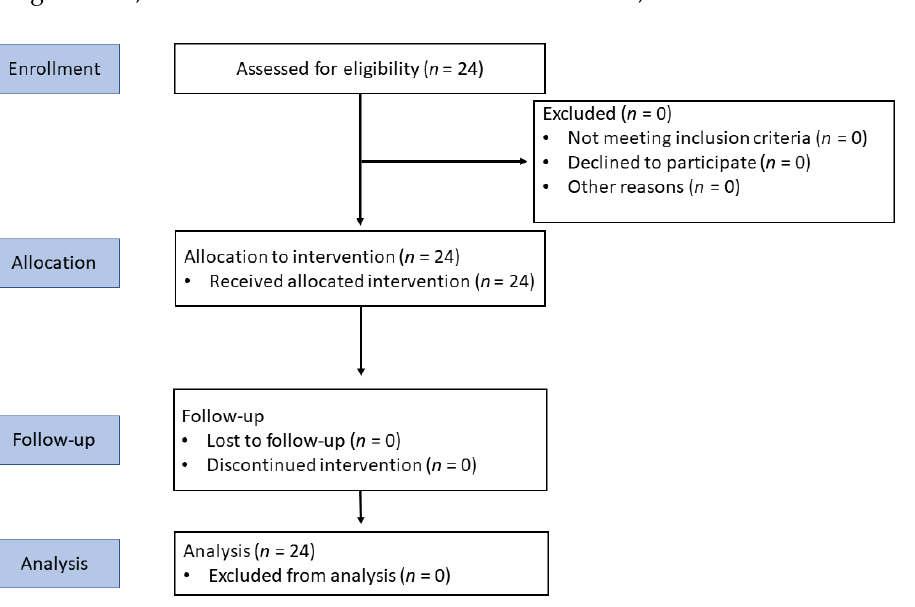
Figure 1. Flow diagram. Twenty-four patients completed the full study protocol.